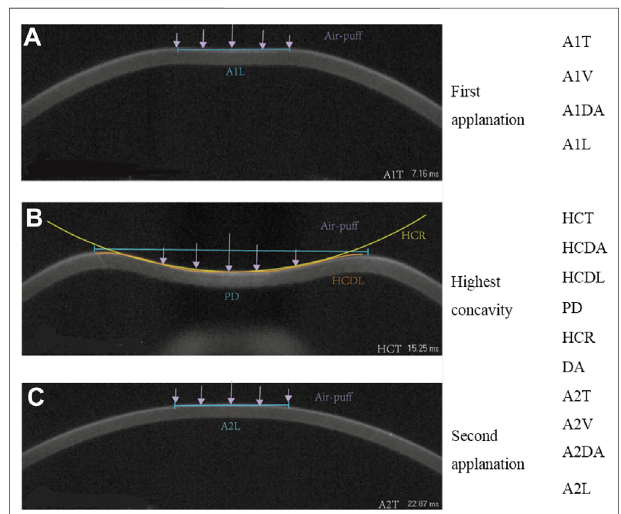
FIGURE 2 | The output parameters of Corvis ST, fi rst applanation (A) , highest concavity (B) , second applanation (C) .